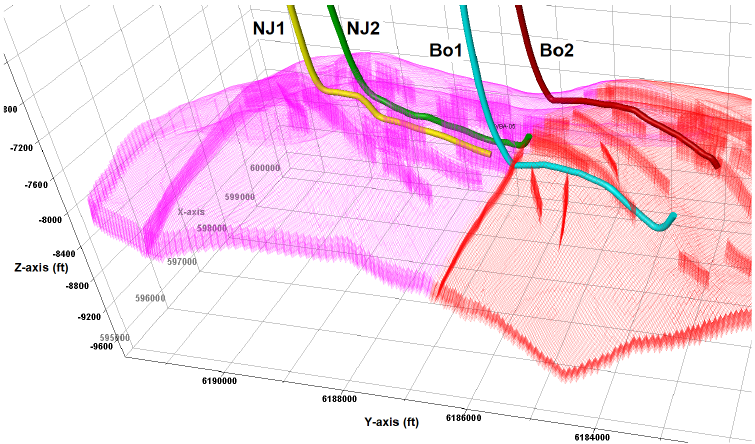
Figure 1. Grid representation of the Valdemar reservoir model with the North Jens sector model (magenta blocks) and the Bo sector model (red blocks), together with the considered production wells. The reservoir model is built in a commercial geological modelling software [18].